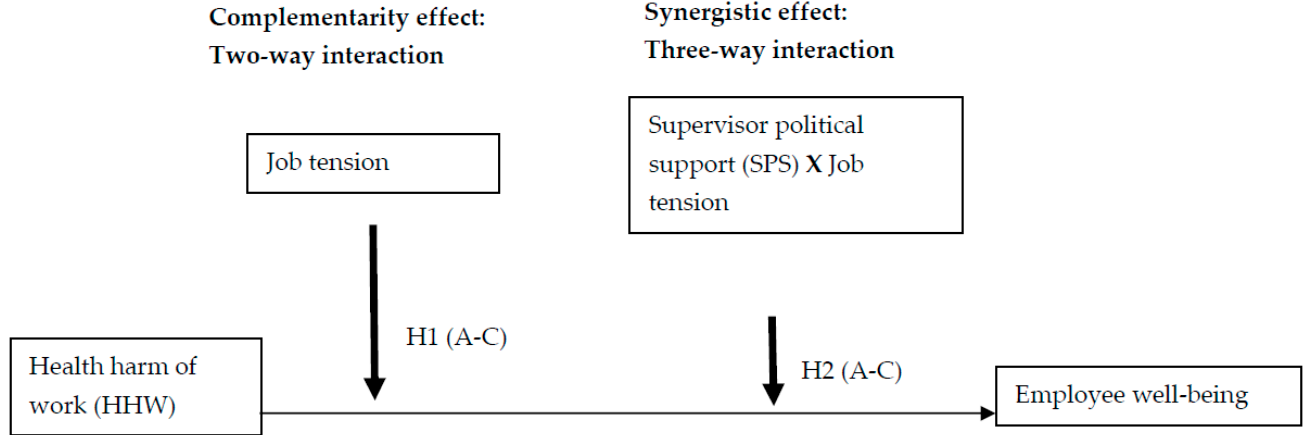
Figure 1. Complementarity and synergistic effects of health harm of work, job tension, and supervisor political support on employee well-being.